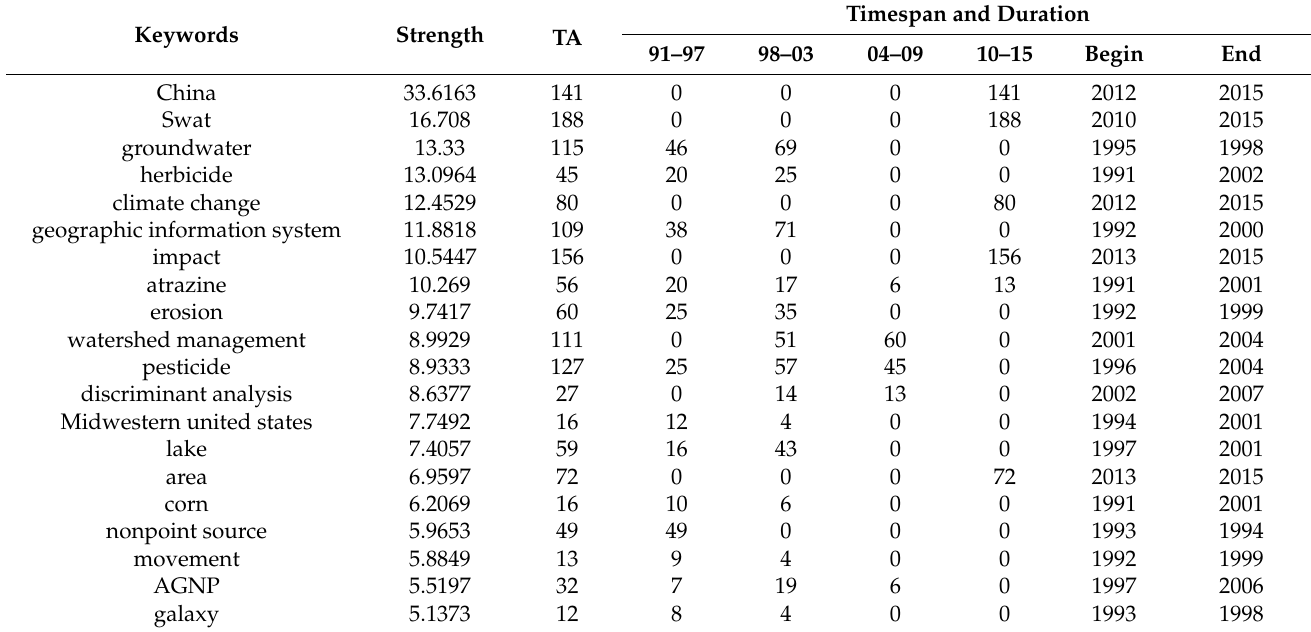
Table 6. The top 20 keywords with strong citation